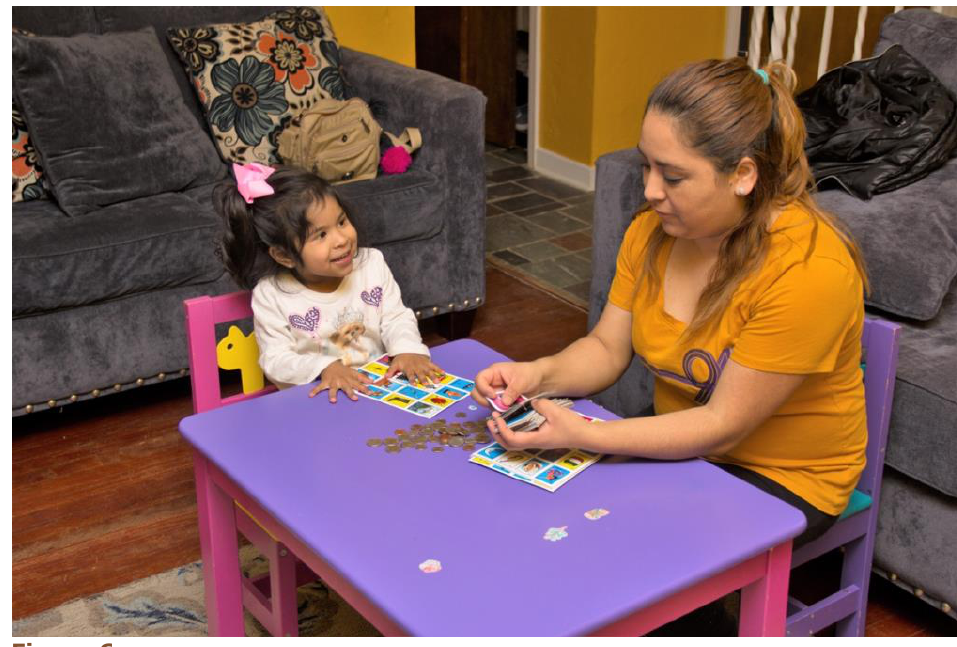
Carolina Genet, Mother and Daughter Playing Lotería , Digital photograph, December 5, 2016. Courtesy of Héctor Camilo Ruiz